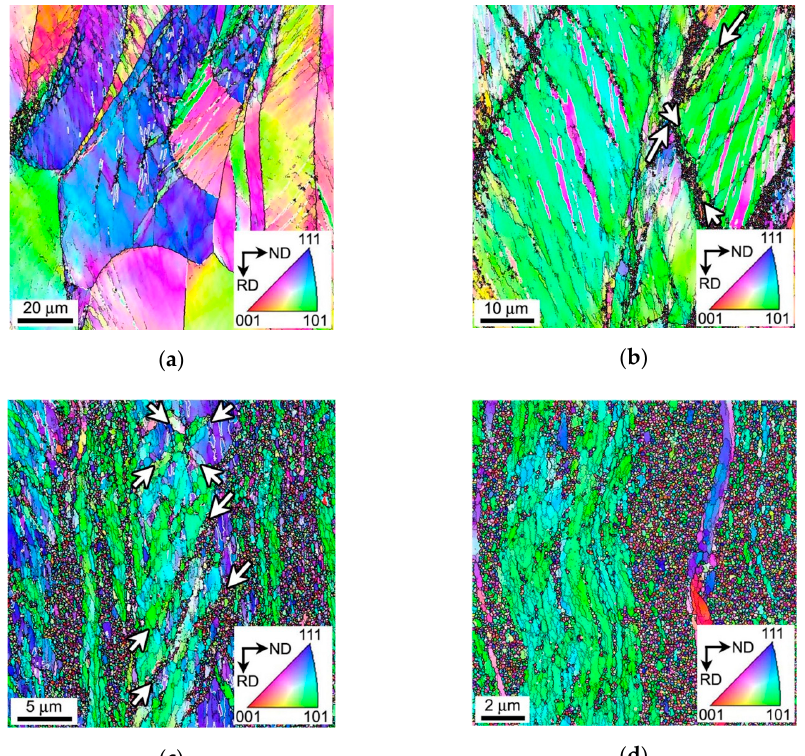
Figure 1. OIM images showing deformation microstructures evolved in a 304L stainless steel during rolling at 473 K to total strains of 0.5 ( a ), 1 ( b ), 2 ( c ) and 3 ( d ). High-angle, low-angle and twin boundaries are indicated by thick black, thin black and white lines, respectively. The inverse pole figures are shown for the normal direction (ND).